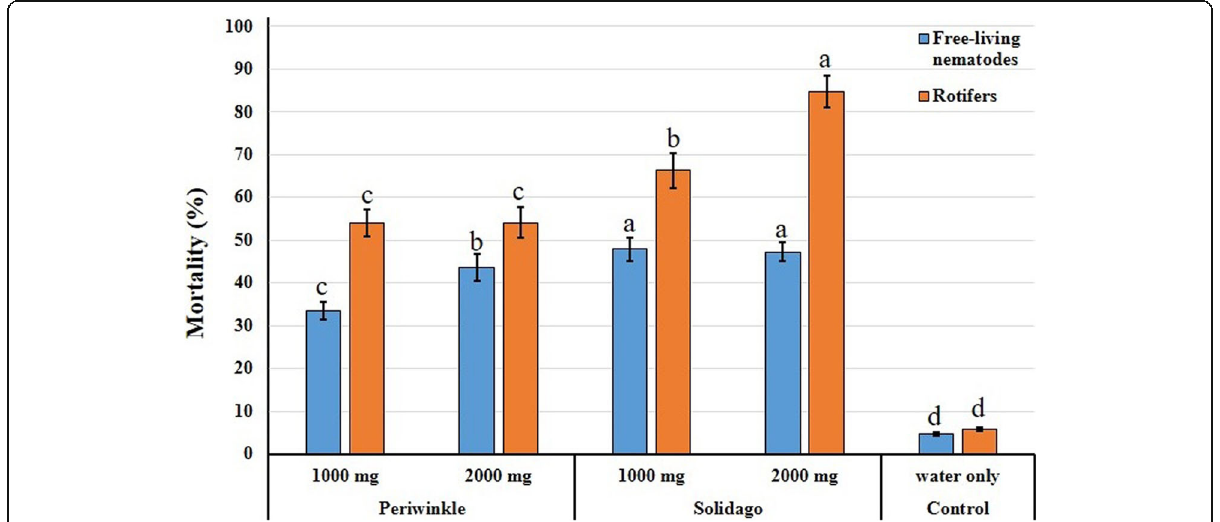
Fig. 2 Efficacy of periwinkle and solidago aqueous extracts on the mortality of free-living nematodes and rotifers after 48 h in vitro . Columns of the same organism bear different letters are significantly different at p < 0.05 according to Duncan ’ s multiple range